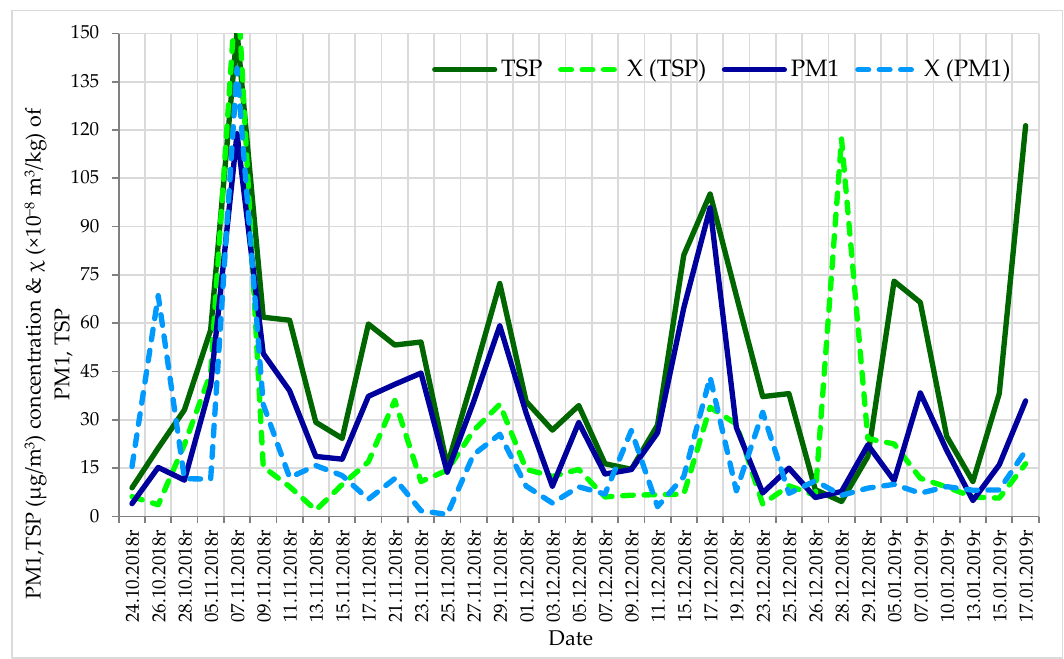
Figure 2. Total suspended particles (TSP) and particles with aerodynamic diameter not greater than 1 µm (PM1) concentration (µg/m 3 ) and mass-specific magnetic susceptibility ( χ , ×10 − 8 m 3 /kg) of daily filters.